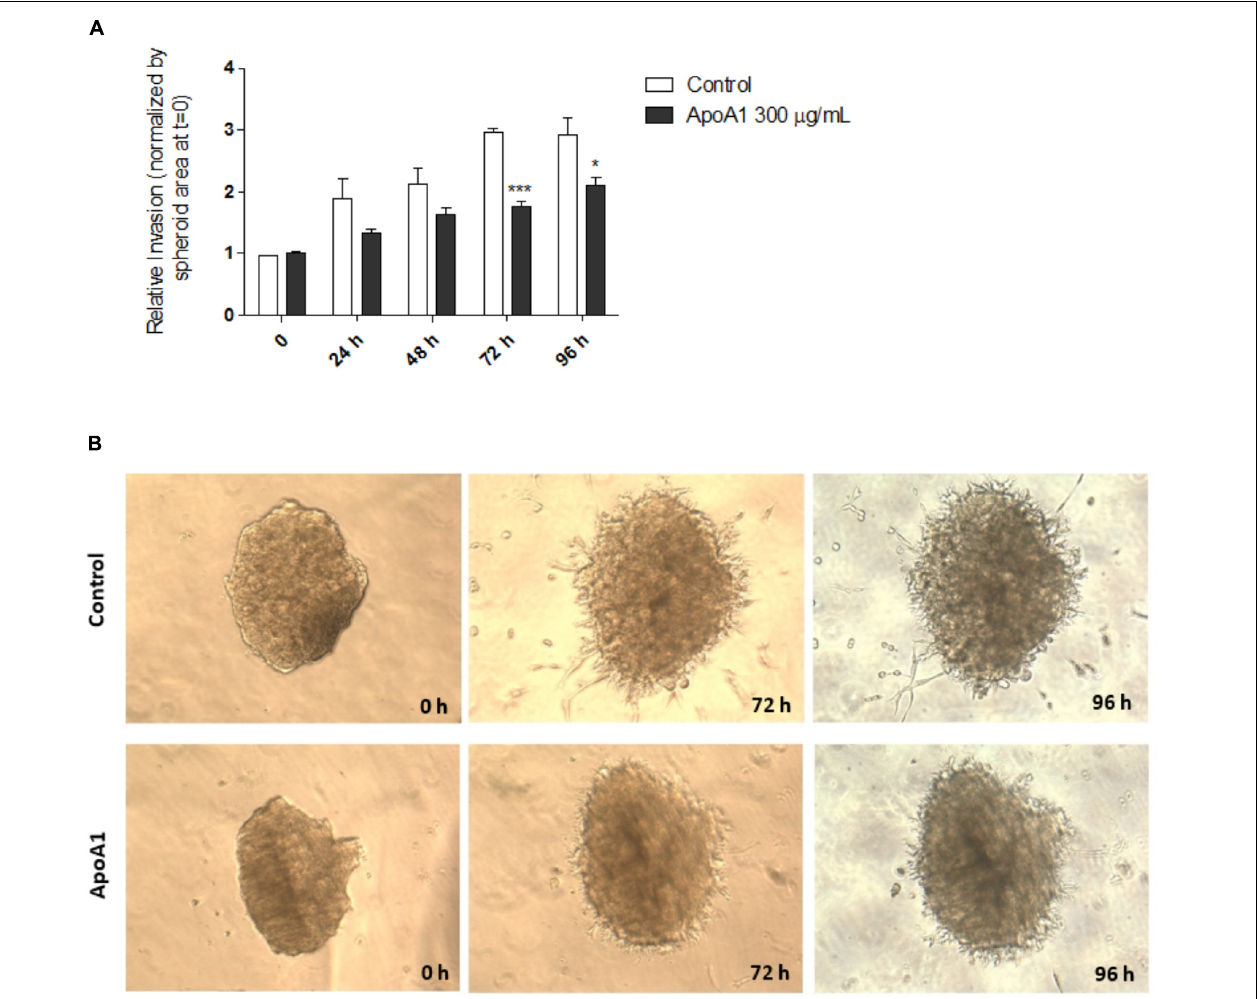
FIGURE 2 | ApoA1 decreases the ability of ovarian cancer cells to invade the extracellular matrix. The 3D tumor spheroid invasion assay was performed in SKOV3 spheroids exposed to ApoA1 at a concentration of 300 µ g/mL, and in unexposed spheroids (control). Invasion of extracellular matrix was assessed for up to 96 h. Exposure to ApoA1 significantly decreased the ability of SKOV3 cells to invade the extracellular matrix after 72 h (Two-way ANOVA; p < 0.001) and 96 h ( p < 0.05). In (A) , the relative invasion normalized to the spheroid area at time = 0 is plotted for ApoA1-treated and untreated spheroids. In (B) , it is shown two spheroids, representatives of the ApoA1-treated and control conditions, at the beginning of the experiment (time = 0) and during the course of experiment (72 and 96 h). Differences were considered significant if p < 0.05. ∗ p < 0.05, ∗∗∗ p < 0.001.